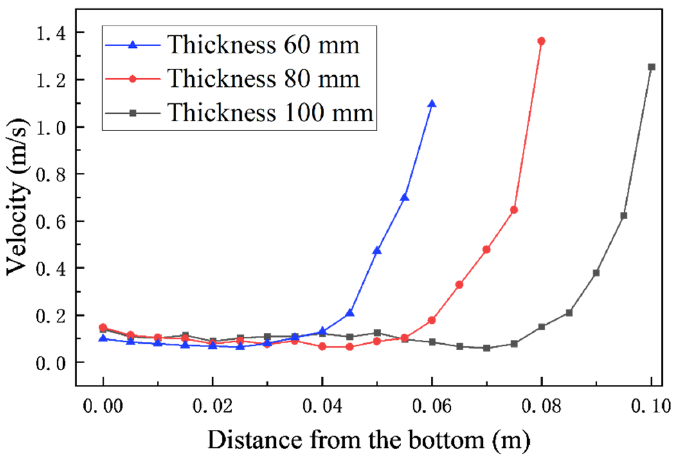
Figure 4. Variation in hot air velocity in heaped tobacco strips.